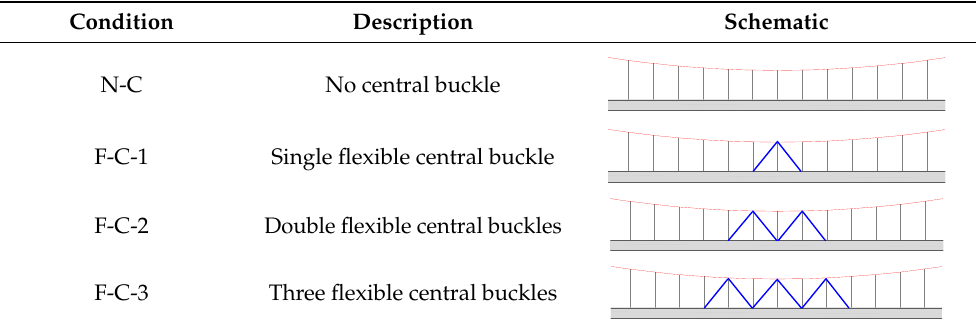
Table 3. Analysis conditions of the FE Table 3. Analysis conditions of the FE model. Table 3. Analysis conditions of the FE model. Table 3. Analysis conditions of the FE model. Table 3. Analysis conditions of the FE model.